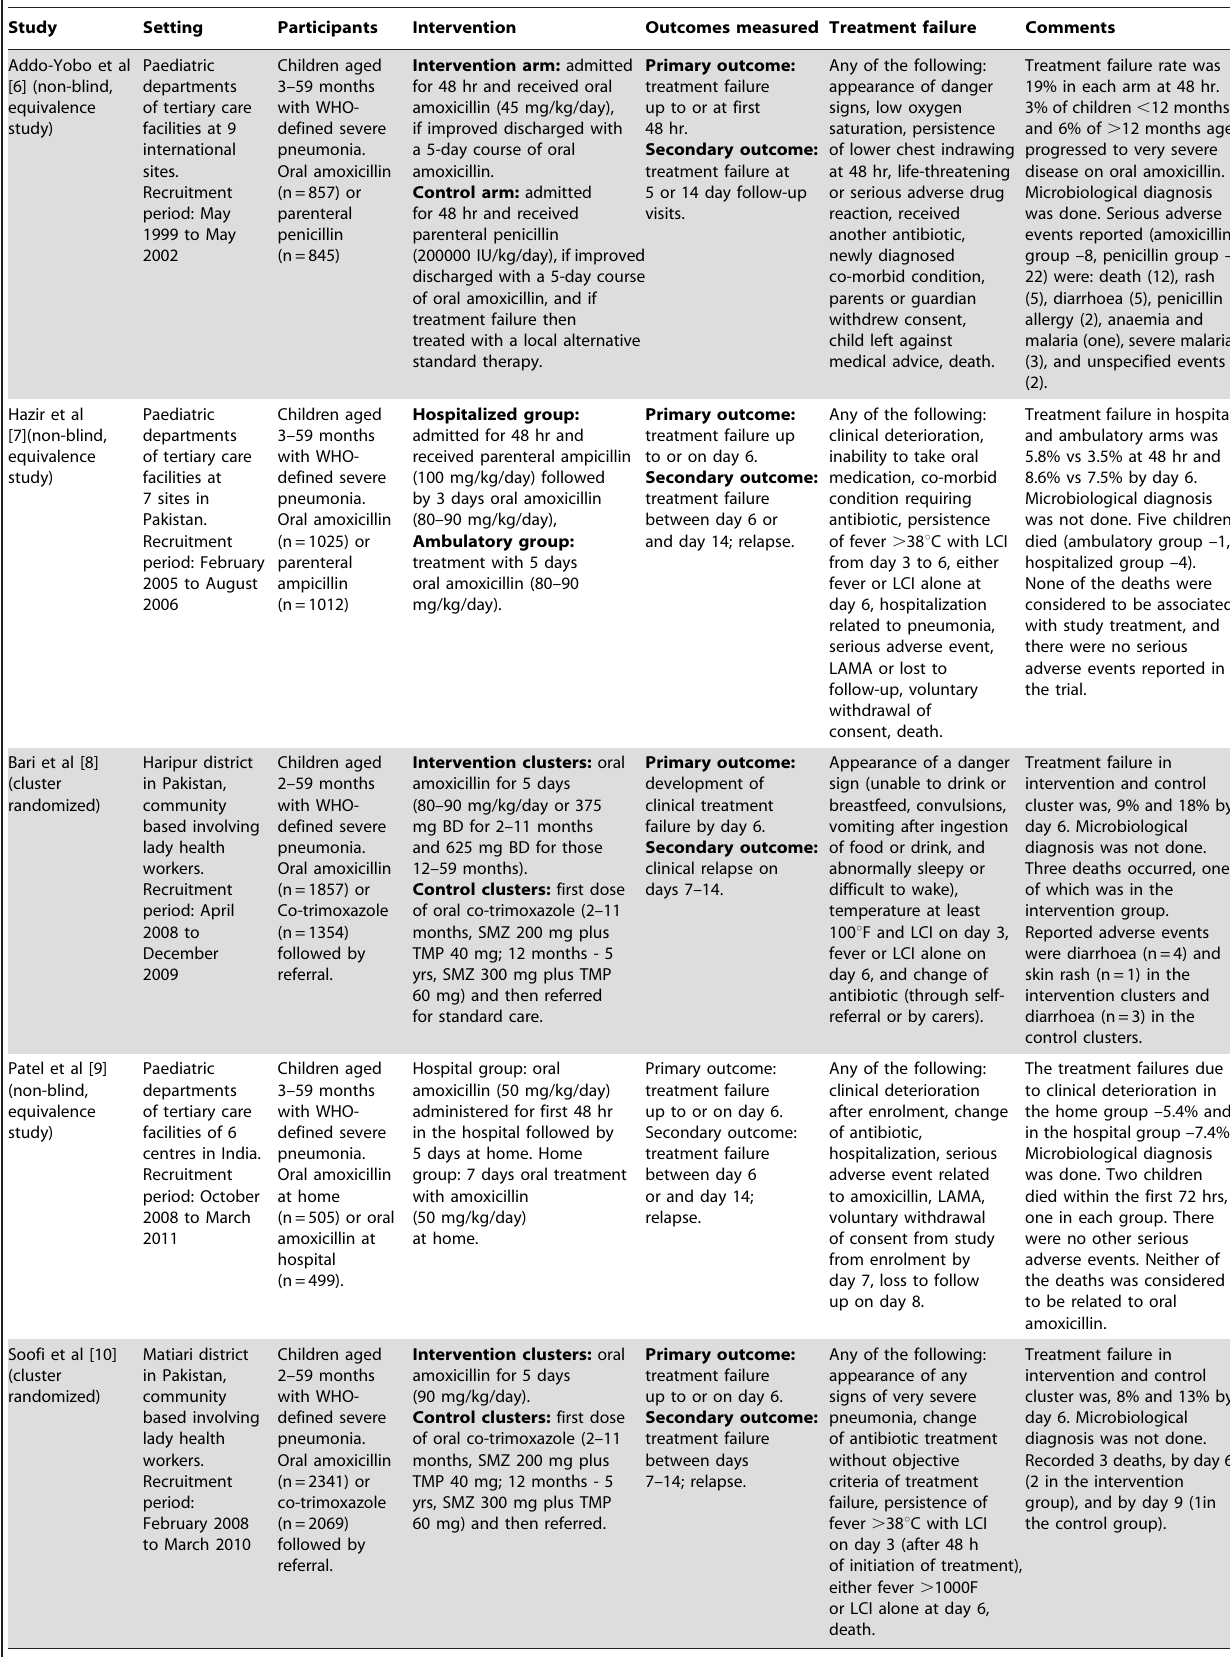
Table 1. Characteristics of included